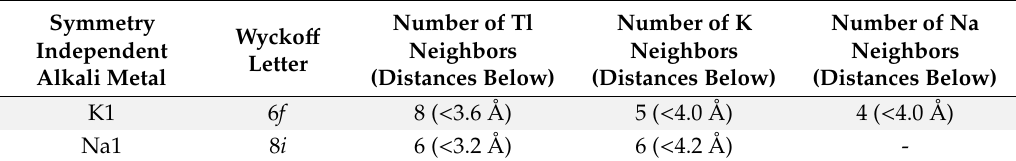
Table 6. Surrounding atoms of the symmetry inequivalent rubidium positions in Na 4 K 6 Tl 13 (space group Im- 3).